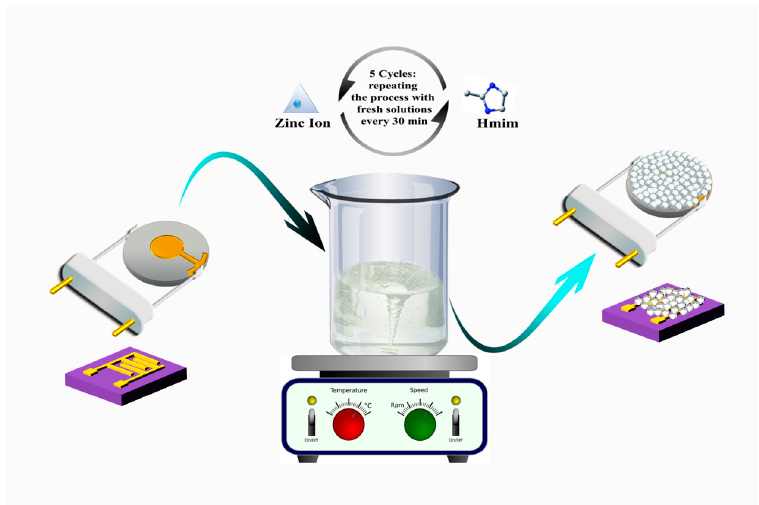
Figure 1. Schematic showing the mechanism used for growing zeolitic–imidazolate framework (ZIF-8) thin films on sensing substrates. The films were deposited by cyclic immersion in a 10-mL mixture of 25 mMol zinc nitrate hexahydrate (5 mL) and 50 mMol 2-Methylimidazole methanolic (5 mL) precursor solutions of [65].